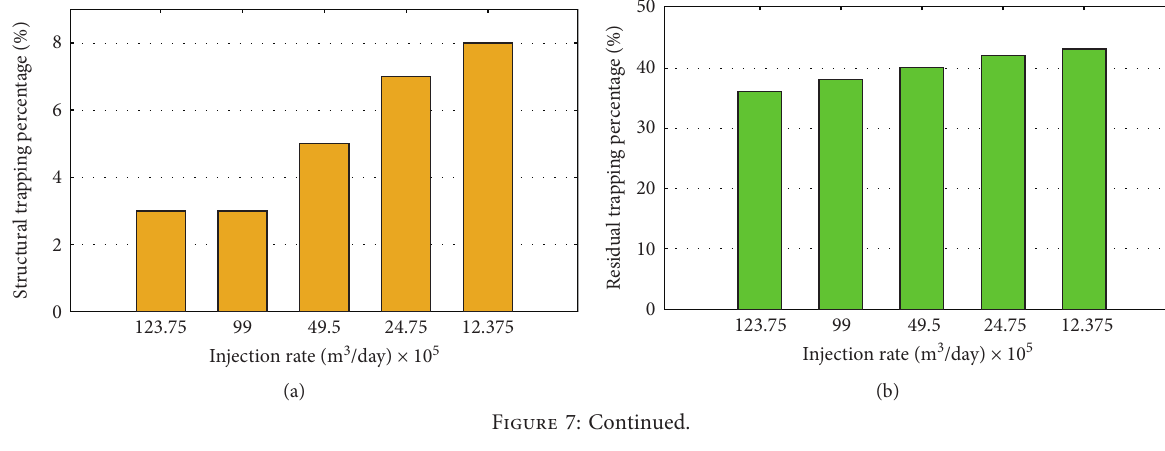
Figure 6: Influence of Deccan traps topography on structural and residual trapping. The illustration represents the movement of CO injecting at various points in the computation